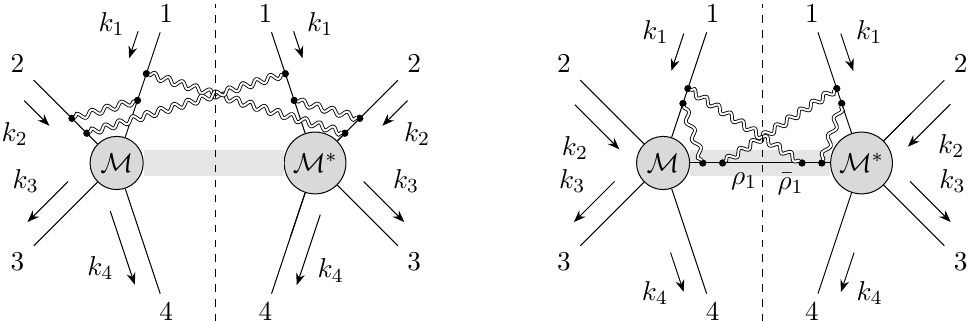
Figure 2. Diagrammatic representation of the contributions to the density matrix variation from primary (left panel) and secondary (right panel) radiation. The vector bosons are represented as double lines to indicate that their momenta have to be integrated over the infinitesimal strip